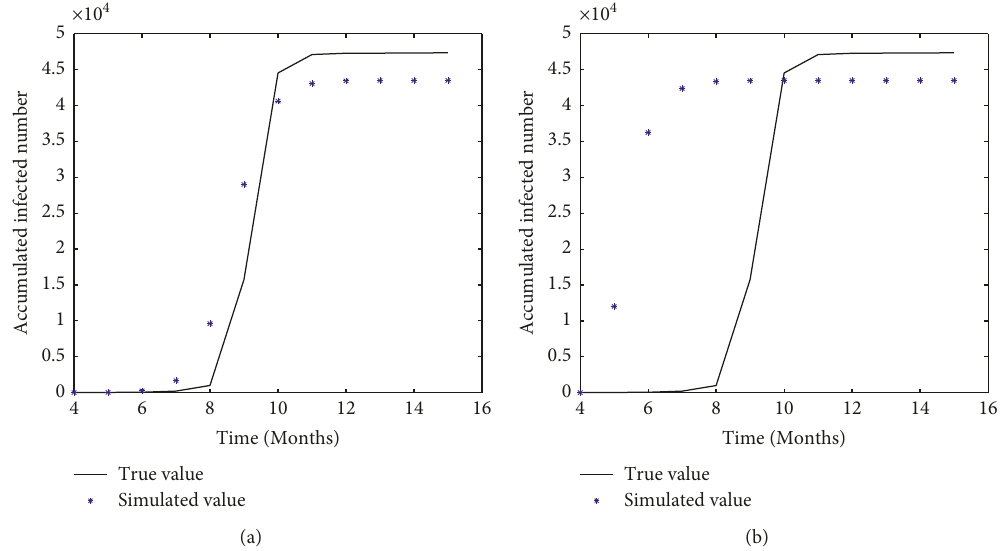
Figure 4: Fitting effect of simulated data and observed data of ABC-SMC algorithm. (a) Logistic model. (b) Gompertz model. Here, the � 5 , T � 6 , t � 12 , ε � 57453 , 22335 , 16047 , 12872 , 11540 , 6720 , and p ( M 1 ) � p ( M 2 ) � 1/2. initial states are n � 6000 ,x 0